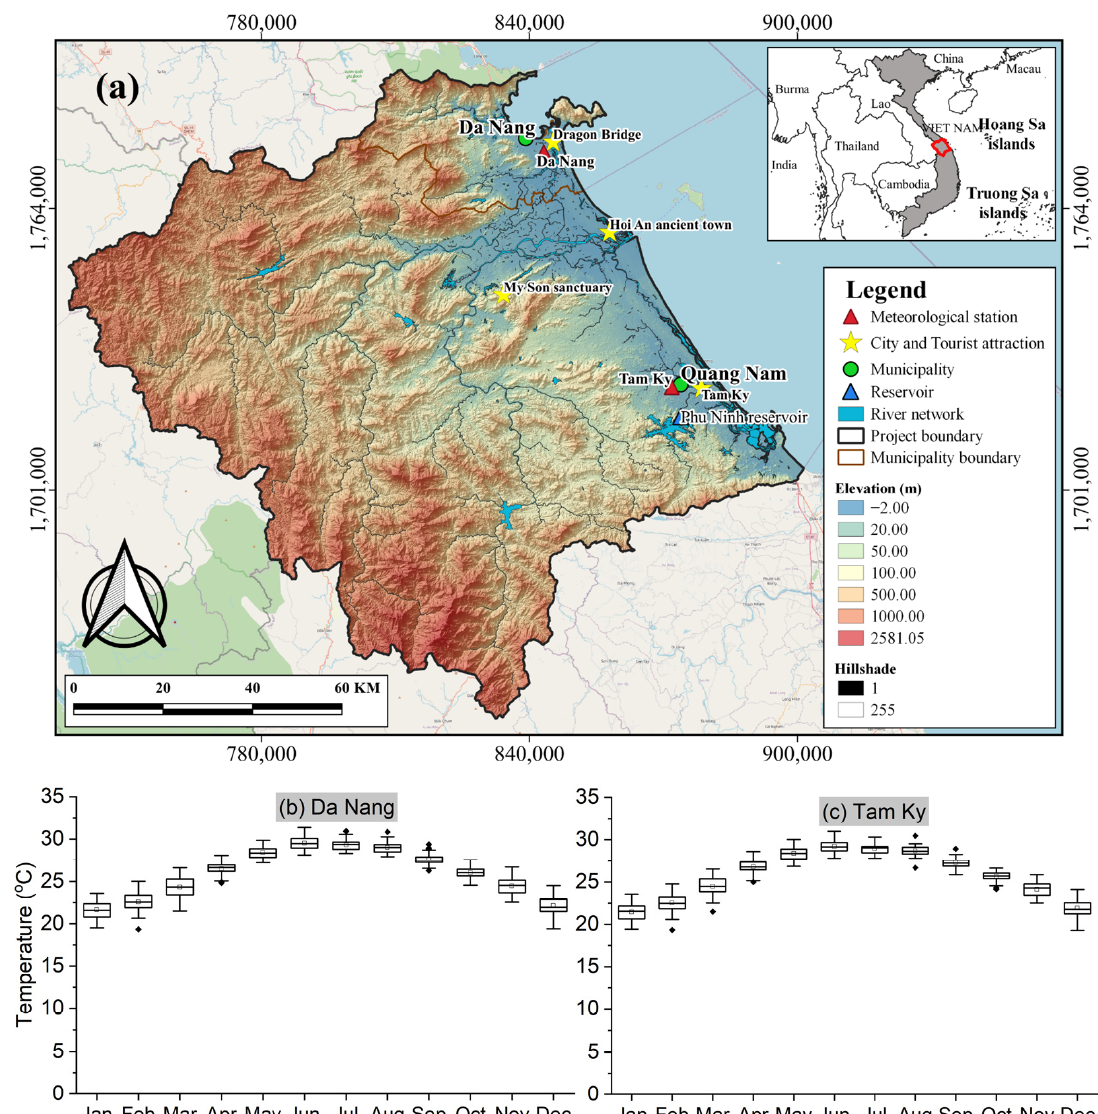
Figure 1. ( a ) Study area of Da Nang city and Quang Nam province; ( b , c ) monthly temperature of Da Nang city and Quang Nam province at Da Nang and Tam Ky meteorological stations, respec- tively.